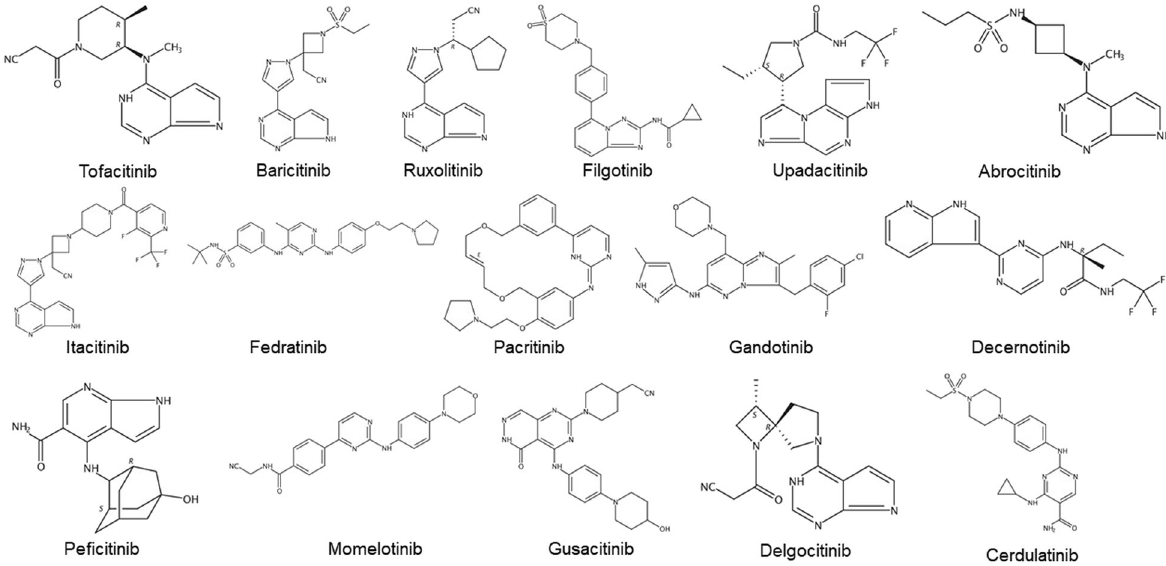
Fig. 6 Chemical structures of JAK